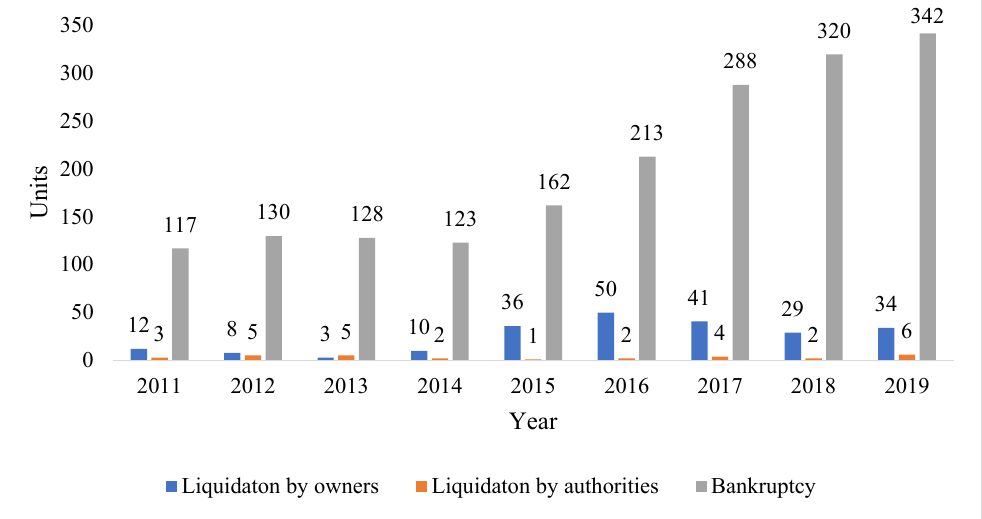
Figure A1. Structure of banks under bankruptcy procedure in 2011–2019.